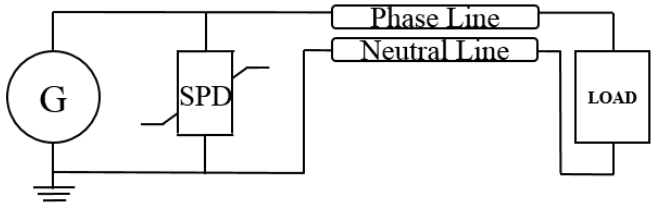
Figure 10. The low-voltage single-phase power system (Model 1).